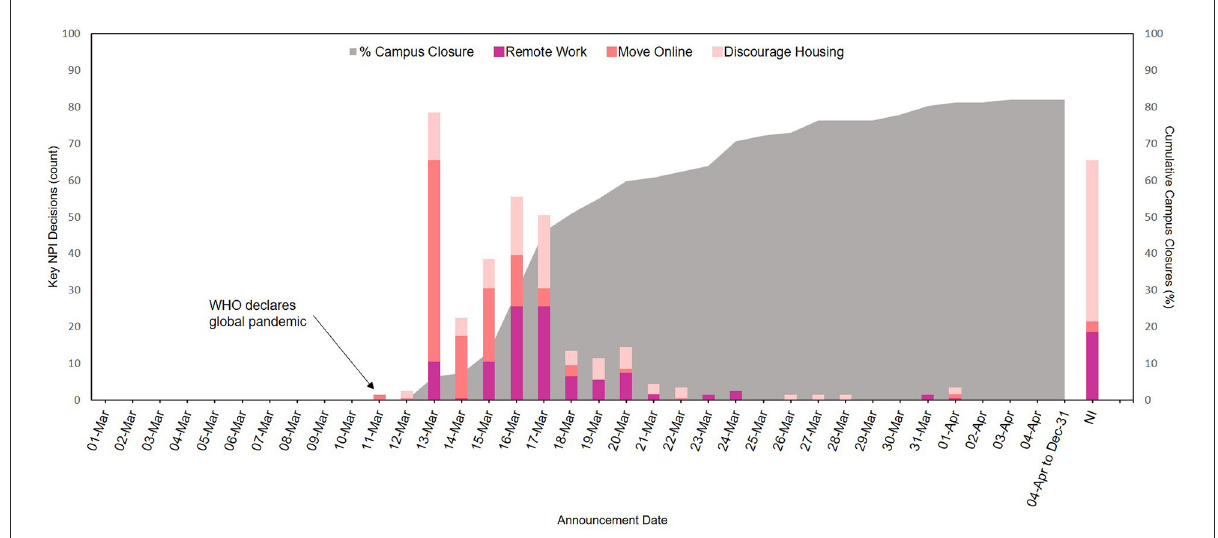
provinces and territories can be attributed to provincial and regional public health authority dialogue.